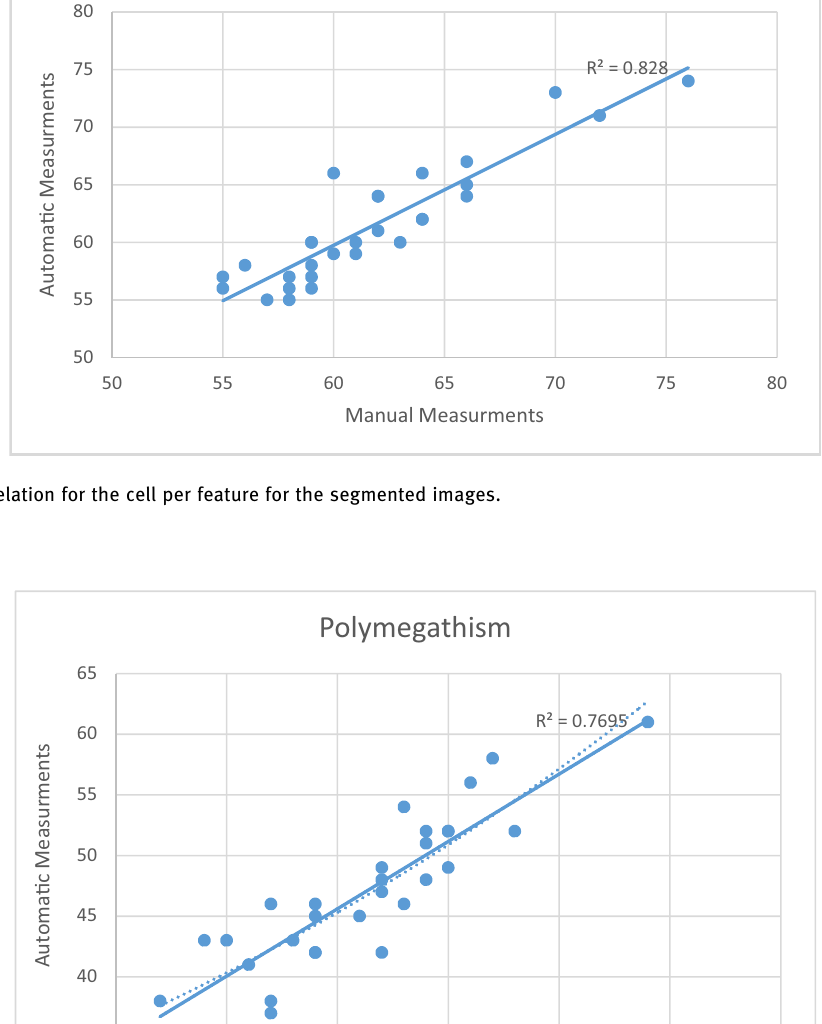
Figure 19: Correlation for the polymegathism feature for the segmented